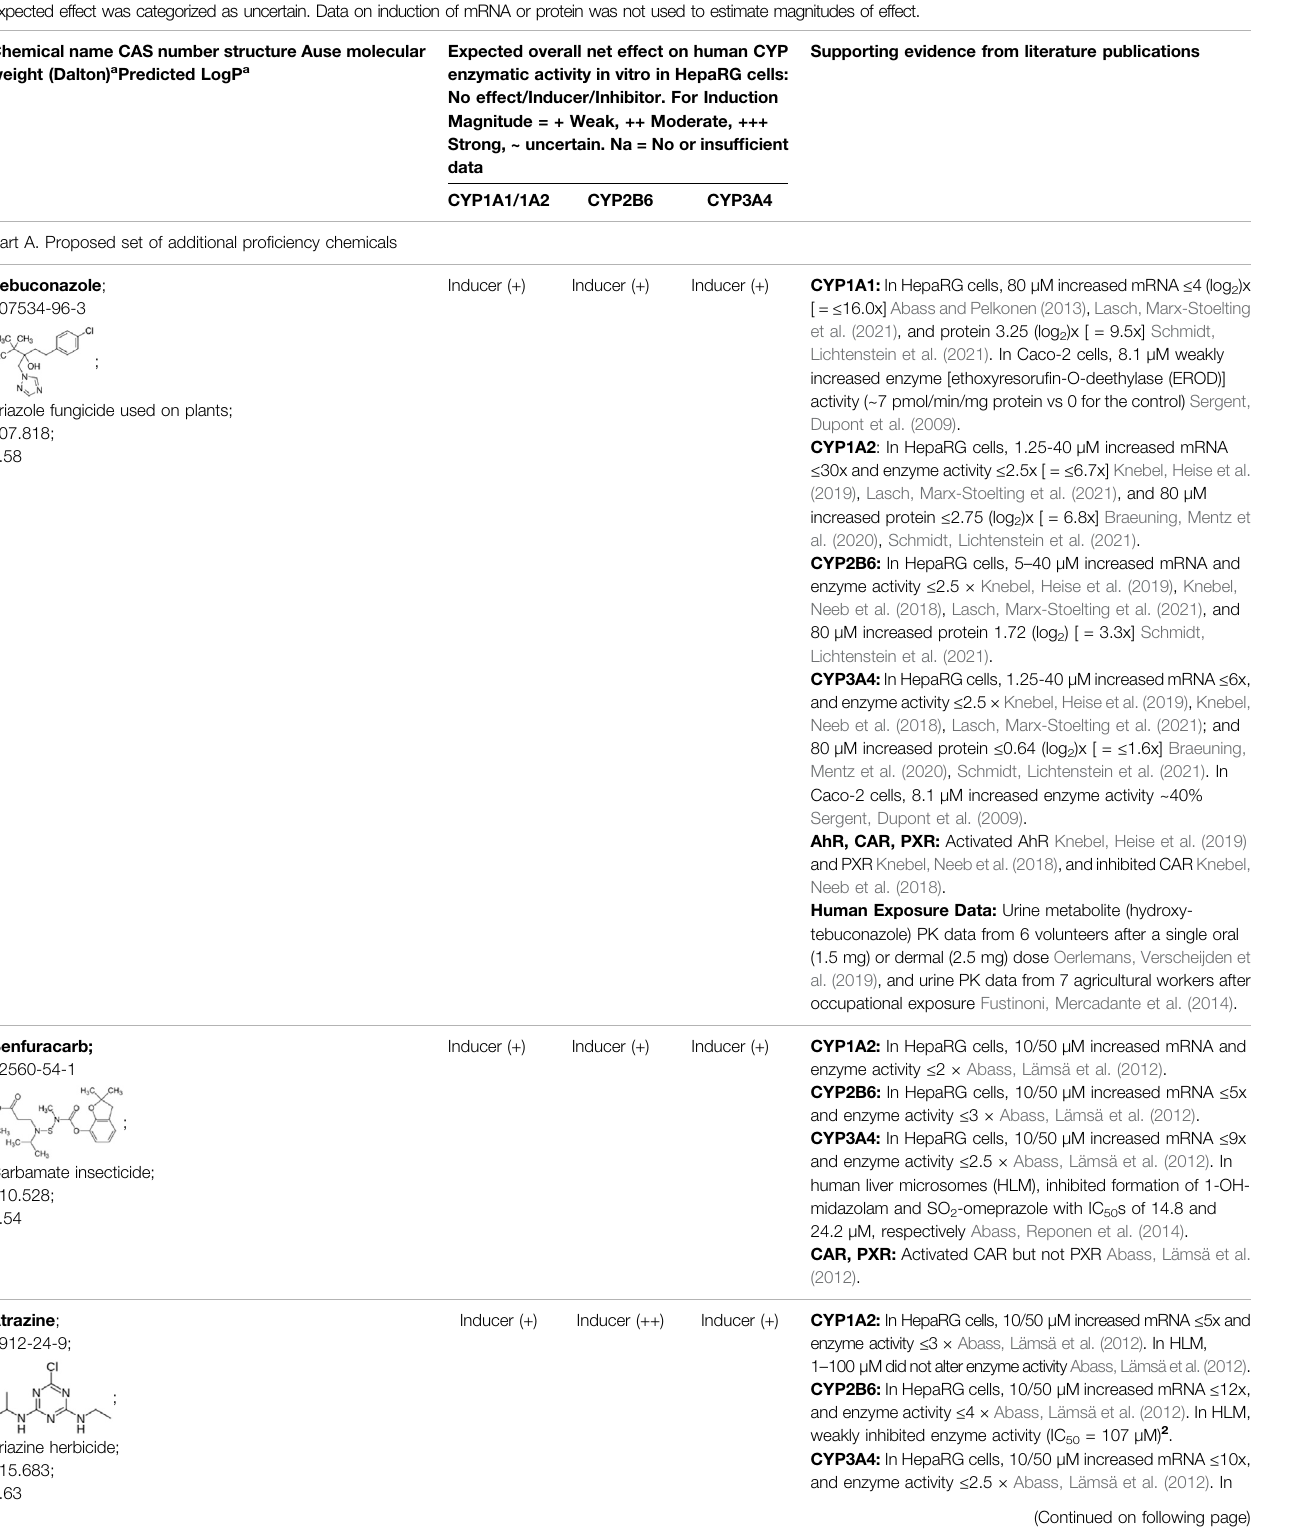
TABLE 1| PartA=Proposed SetofAdditional Industrial, Pesticidal,andFoodAdditivePro fi ciencyChemicalstoUseinFurtherCYPInductionValidationExperiments.PartB=Initial CandidateSelectionPoolChemicalsthatwereEvaluatedbutNotSelected.ThemagnitudeofanyobservedCYPenzymeinductionwascategorizedaslow( ≤ 3fold),moderate( > 3to 4.5 fold), and or strong ( > 4.5 fold), when data from cell-based enzymatic activity assays was available. When cell-based enzymatic data was absent (not tested), the magnitude of an expected effect was categorized as uncertain. Data on induction of mRNA or protein was not used to estimate magnitudes of